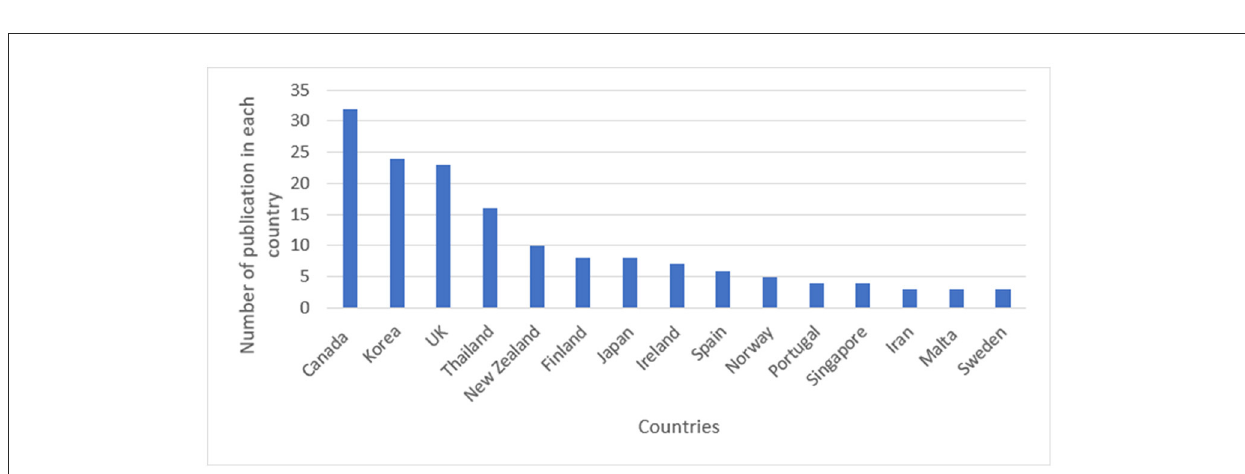
FIGURE3 Frequency distribution of published documents on NCDs strategy per